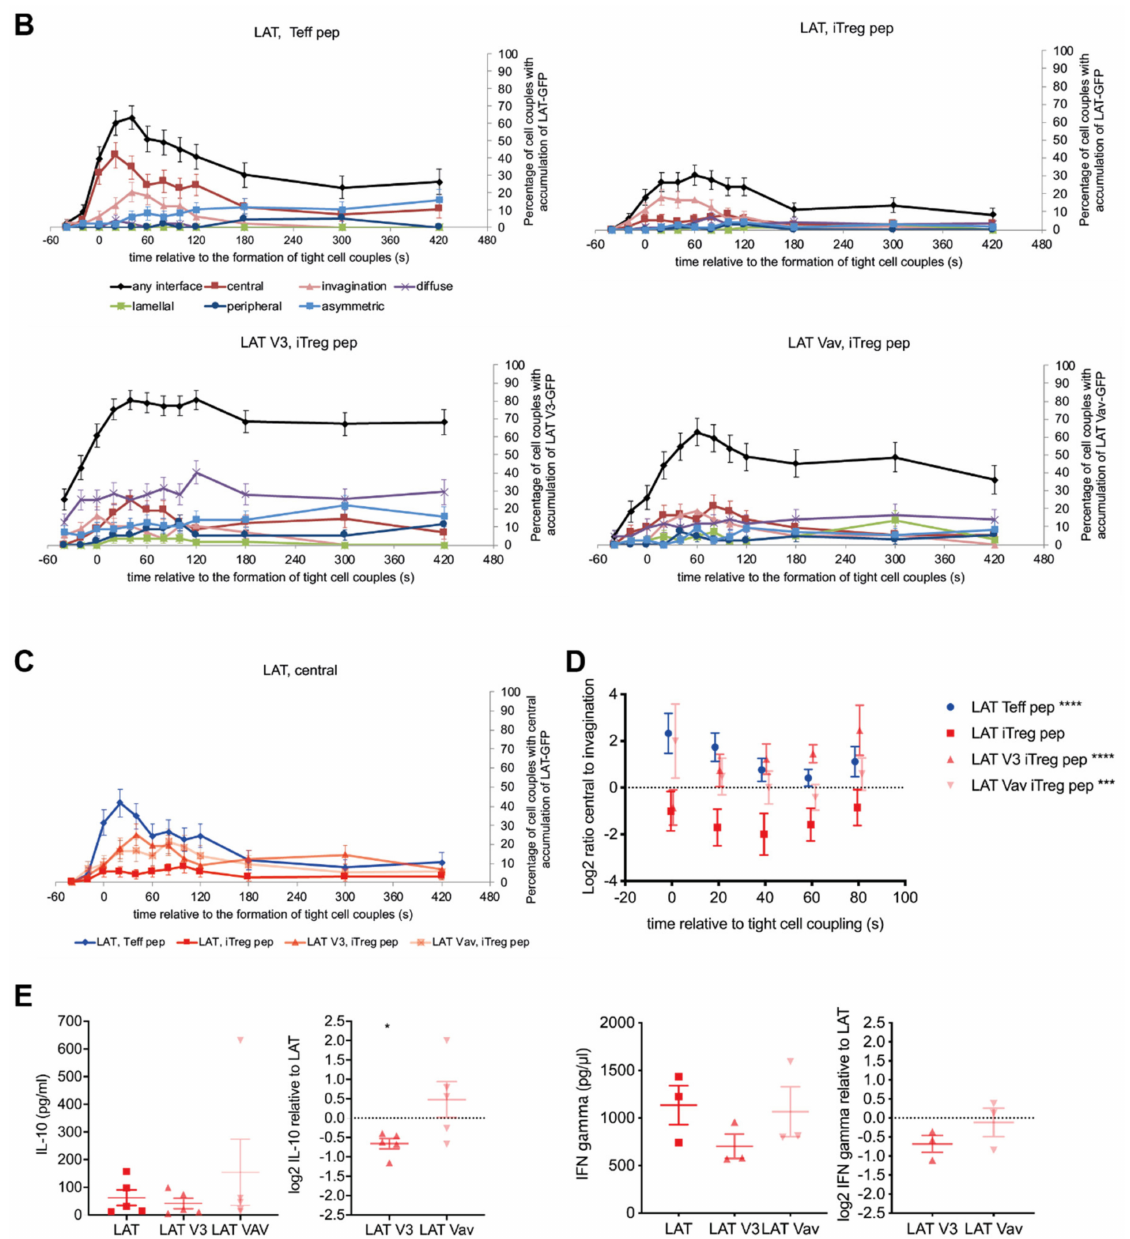
Figure 6. cSMAC formation can be partially restored with synthetic approaches in Tg4 iTreg pep cells. ( A – D ) Tg4 T cells as indicated transduced to express LAT-GFP, LAT V3-GFP or LAT-Vav were activated with PL8 APCs (10 µ g/mL Ac1-9[4Y]). ( A ) Representative LAT V3-GFP and LAT-Vav imaging data as in Figure 2A. A video corresponding to the LAT-V3-GFP data is available as Video S8. ( B , C ) Data are expressed as the percentage of cell couples with LAT-GFP, LAT-V3-GFP or LAT Vav-GFP accumulation as noted in the indicated patterns (Supplementary Figure S2A) relative to tight cell couple formation. Number of cell couples analyzed are n = 57, 43 for iTreg pep cells expressing LAT V3-GFP and LAT Vav-GFP, respectively, from 4 and 2 independent experiments. LAT-GFP data are from Figure 2B. Statistical significance of differences between conditions is given in Table S8; ( B ) all patterns for each cell type and LAT construct separately; ( C ) only central accumulation in direct comparison between the cell types and LAT constructs; ( D ) The same data are expressed as the log 2 of the ratio of percent Tg4 T cells with accumulation in the central over the invagination pattern relative to tight cell couple formation. LAT-GFP data are from Figure 2D. Data points are slightly nudged to increase legibility. E Tg4 iTreg pep cells transduced to express LAT-GFP, LAT V3-GFP or LAT-Vav were activated with PL8 APCs (10 µ g/mL Ac1-9[4Y]) for 18 h. Data are expressed as amount of IFN γ and IL-10 in tissue culture supernatants from 3 independent experiments, each, and also as the log2 of the ratio of IFN γ and IL-10 in iTreg pep cells expressing LAT V3-GFP or LAT Vav-GFP relative to those expressing